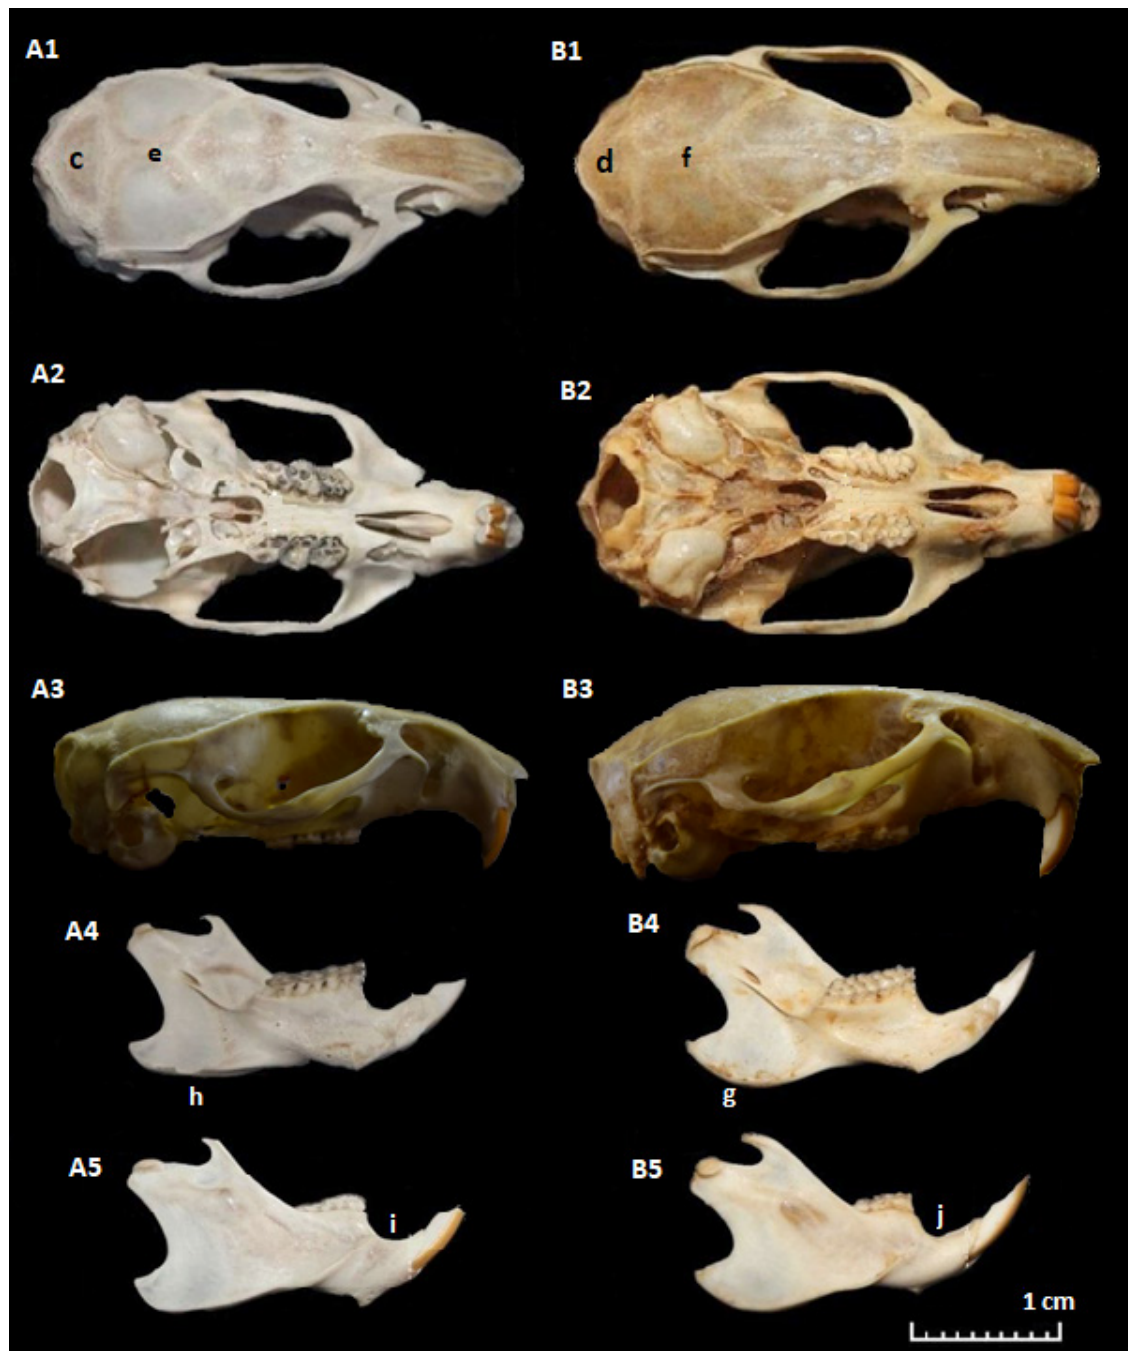
Figure 3: Craniums and mandibule of Golunda ellioti ellioti (PDZ 7) (A) and G. e. nuwara (WHT M 141) (B). 1: Dorsal view of cranium, 2: Ventral view of cranium, 3: Lateral view of cranium, 4: Lateral view of mandible on lingual surface, 5: Lateral view of mandible on labial surface. G. e. ellioti from Sri Lanka and 1.8% distance with G. e. nuwara